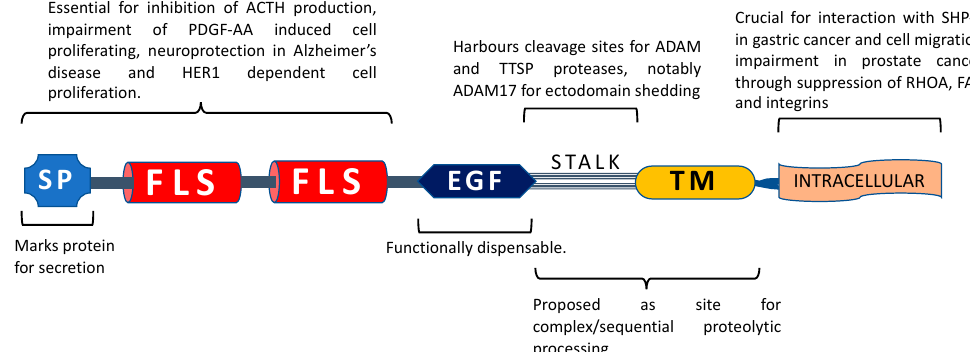
Figure 2. TMEFF2 domain functionality. SP: signal peptide, FLS: follistatin-like domain, EGF: EGF-like domain, TM: transmembrane domain. The N-terminal portion of TMEFF2 with signal peptide and follistatin-like domains is deemed crucial for impairment of adrenocorticotropic hormone (ACTH) production through inhibition of corticotropin release hormone (CRH) signalling in glioma cells, neuroprotection in Alzheimer’s disease, binding with PDGF-AA and induction of proliferation in HEK293 cells, whereas the EGF-like domain is dispensable for all of these functions. The stalk sequence (residues 303–320) is essential for ADAM17-mediated ectodomain shedding and harbours 2 potential cleavage sites for Type II transmembrane serine proteases (TTSPs). TTSPs like matriptase-1 and hepsin can cause TMEFF2 shedding independent of stalk region. Proteolytic processing of the ectodomain and remaining stub could impact TMEFF2 function. The TMEFF2 intracellular region is necessary for interaction with SHP-1 in gastric cancer cells and TMEFF2-induced impairment of cell migration in prostate cancer.